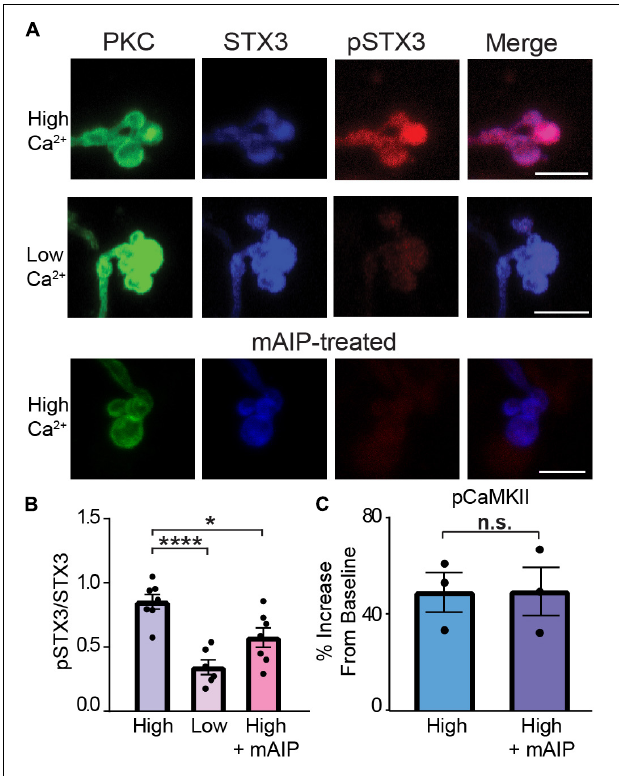
FIGURE 7 | CaMKII phosphorylates STX3B at T14 in rod bipolar cell synaptic terminals. (A) Confocal images of synaptic terminals of isolated rod bipolar cells, identified by their characteristic morphology and PKC immunoreactivity (green), demonstrate an increase in pSTX3 immunoreactivity (red) under conditions of elevated intraterminal Ca 2 + (“High Ca 2 + ”) compared to those incubated in a nominally 0 Ca 2 + external solution (“Low Ca 2 + ”). Treatment with myristoylated AIP (“mAIP,” 100 nM, and lower panel) blocked the expected Ca 2 + -evoked increase in pSTX3 immunoreactivity. Scale bar = 5 µ m. (B,C) Quantification of the pSTX3/STX3 ratio in rod bipolar cell terminals. AIP inhibited the Ca 2 + -evoked rise in the pSTX3/ST3 ratio ( p =